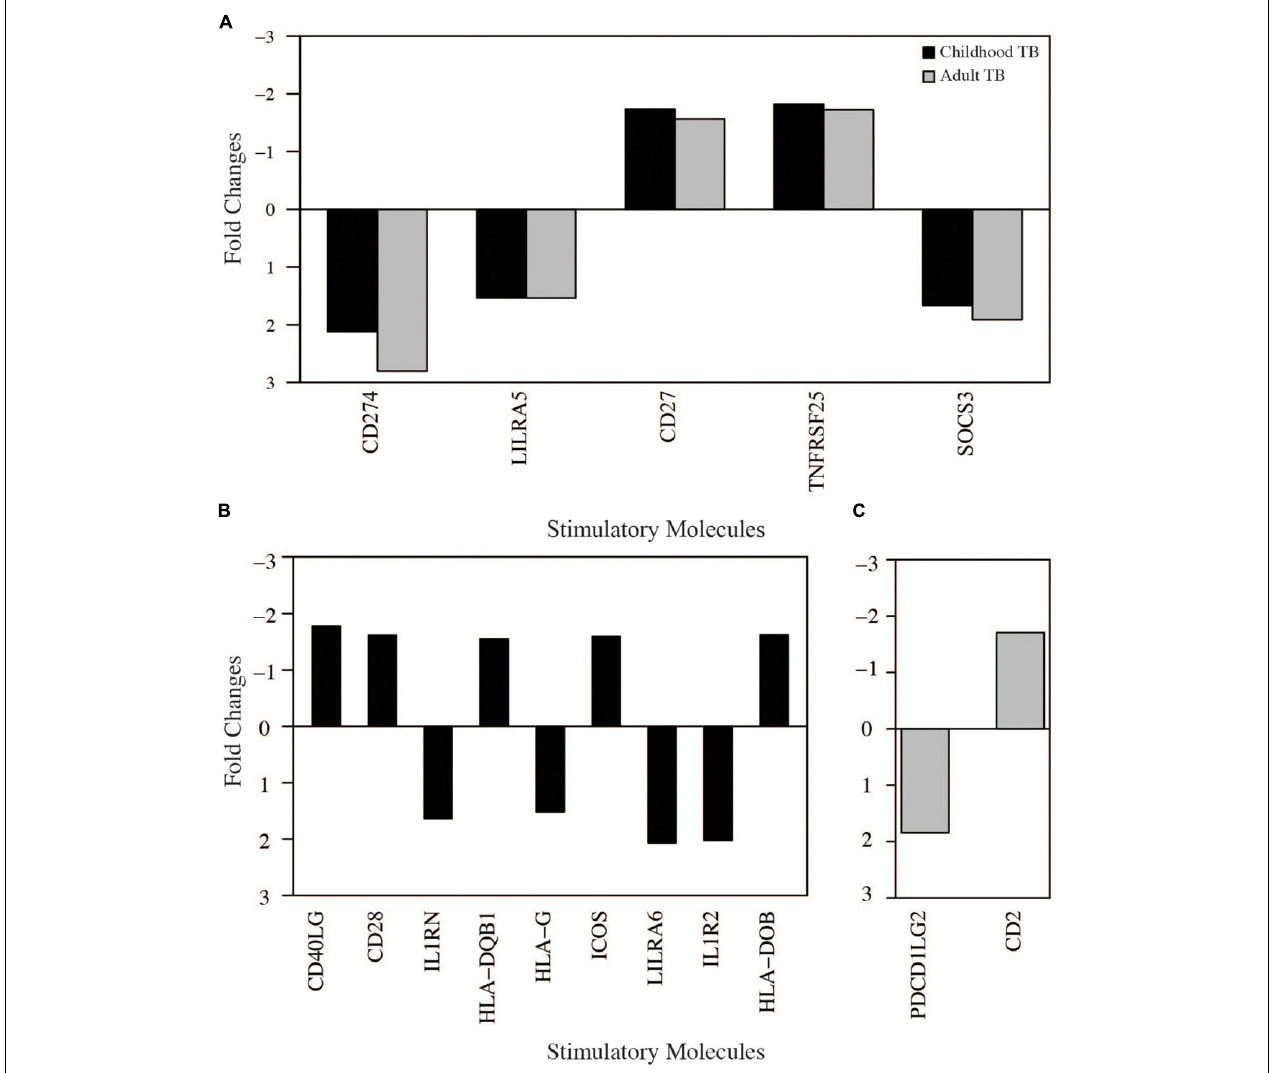
FIGURE 9 | Immune cell signaling molecules modulated in tuberculosis. Significantly regulated immune cells stimulatory and inhibitory molecules obtained from tuberculosis in the meta-analysis (fold change > 1.5 adjusted p -value < 0.05). (A) Molecules modulated in both adults and childhood tuberculosis. (B) Molecules modulated only in childhood tuberculosis. (C) Molecules modulated only in adult